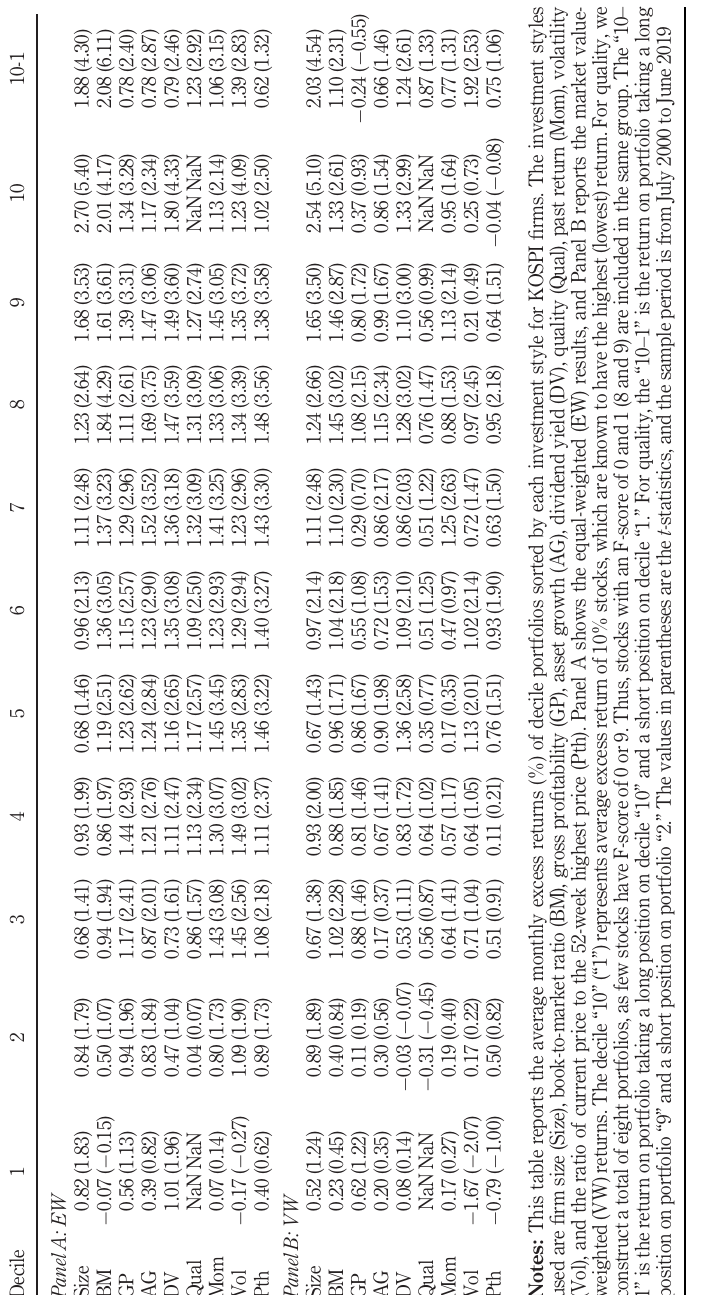
returns of the decile portfolios: KOSPI